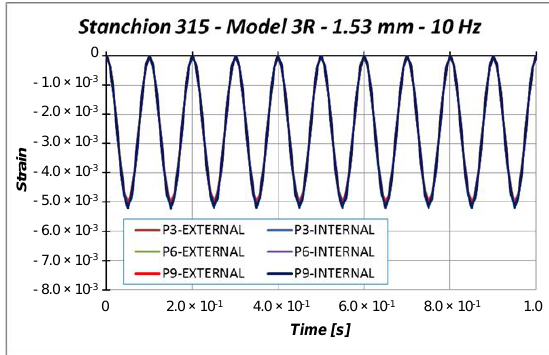
Figure 21. Strain: 1.53 mm applied displacement.